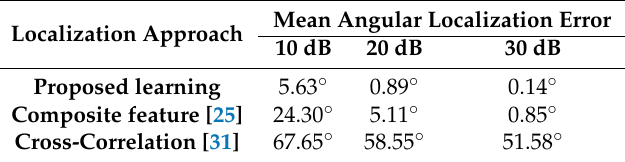
Table 1. 3-D space localization performance